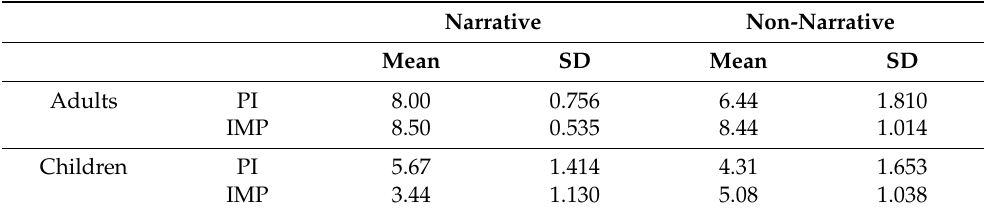
Table 3. Means and standard deviations of expected responses for both age groups and settings (the maximum is 9).